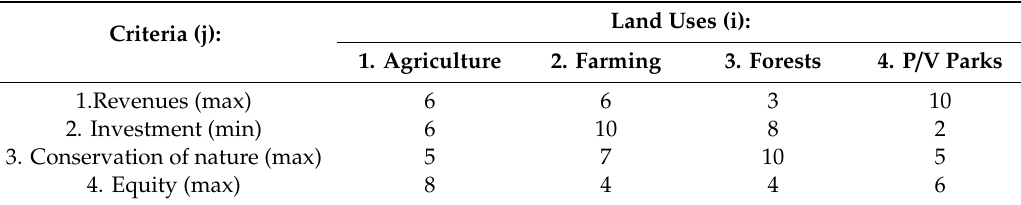
Table 3. Rating of land uses for each of the four examined criteria. Criteria (j):